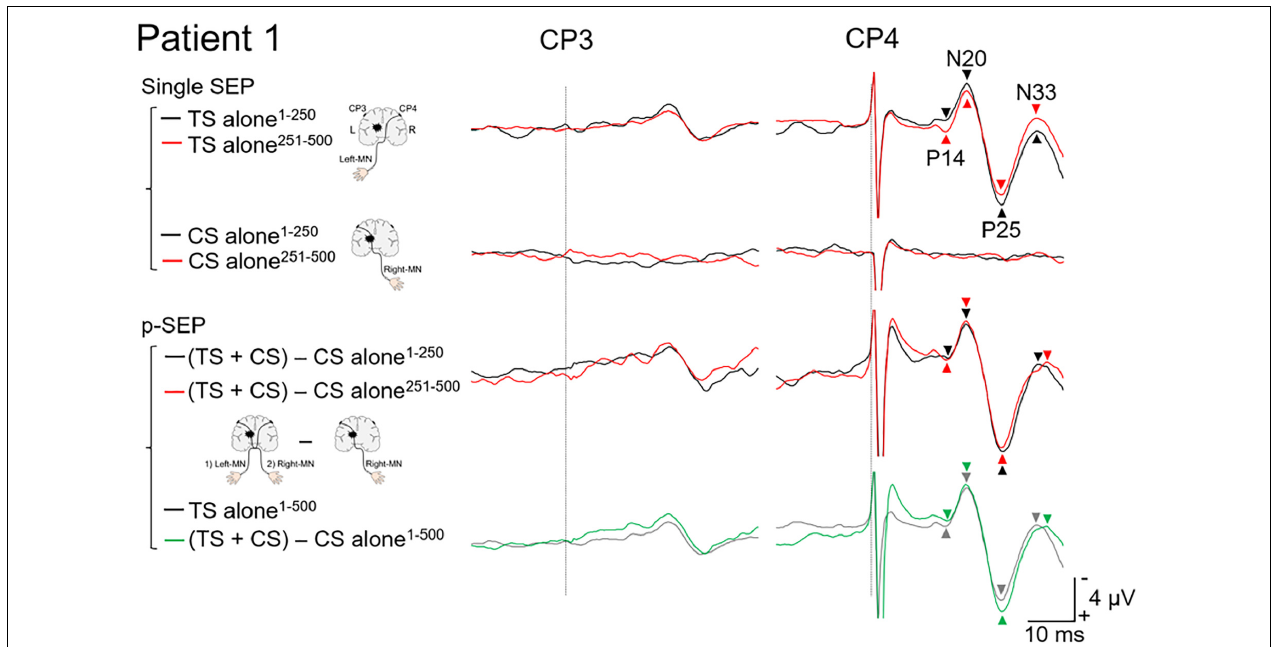
FIGURE 2 | Paired median nerve somatosensory evoked potential in patient 1. Left panels : to investigate the effect of the conditioning stimulus (CS) on the SEP induced by the test stimulus (TS), the single median nerve SEPs (single SEP) (right-MN: CS alone), and the paired median nerve SEPs (p-SEP) were recorded at the CP3 and CP4 electrodes (Ragert et al., 2011). In the p-SEP recording, the right-MN stimulus (CS) was performed 1 ms after the left-MN stimulus (TS). Right panels : all SEP waveforms at CP3 and CP4 from patient 1. We compared the SEP averaged over the first 250 epochs with the SEP averaged over the second 250 epochs (total number of epochs recorded: 500). Black line: the SEP averaged over the first 250 epochs. Red line: the SEP averaged over the second 250 epochs. Gray line: the SEP averaged over all epochs (500 epochs) (TS alone condition). Green line: the SEP averaged over all epochs (500 epochs) [(TS + CS) − CS alone condition]. Dotted line: the time duration of stimulation. MN, median